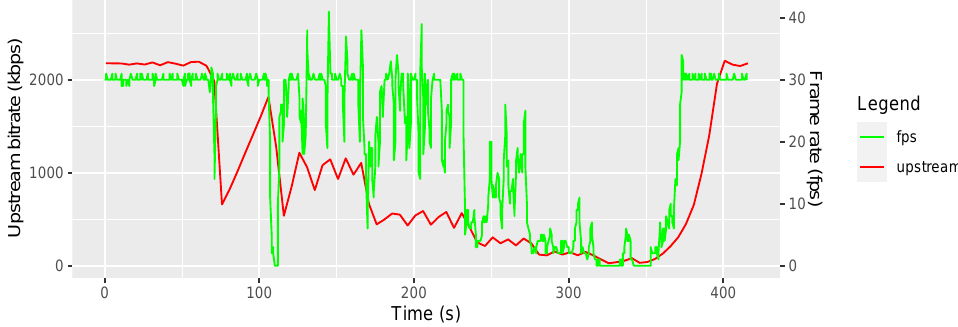
Figure 24. Frame rate in frames per second (fps) over time depending on a variable upstream band-